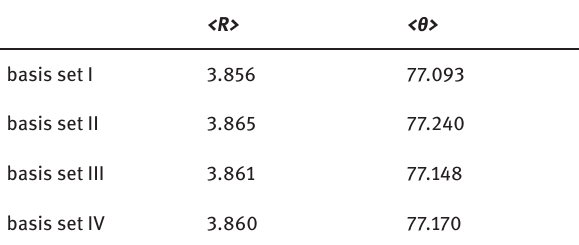
Table 5: The average structural parameters for the ground vibrational states of the C -Ar complex ( R in angstrom and angles in degree). 3